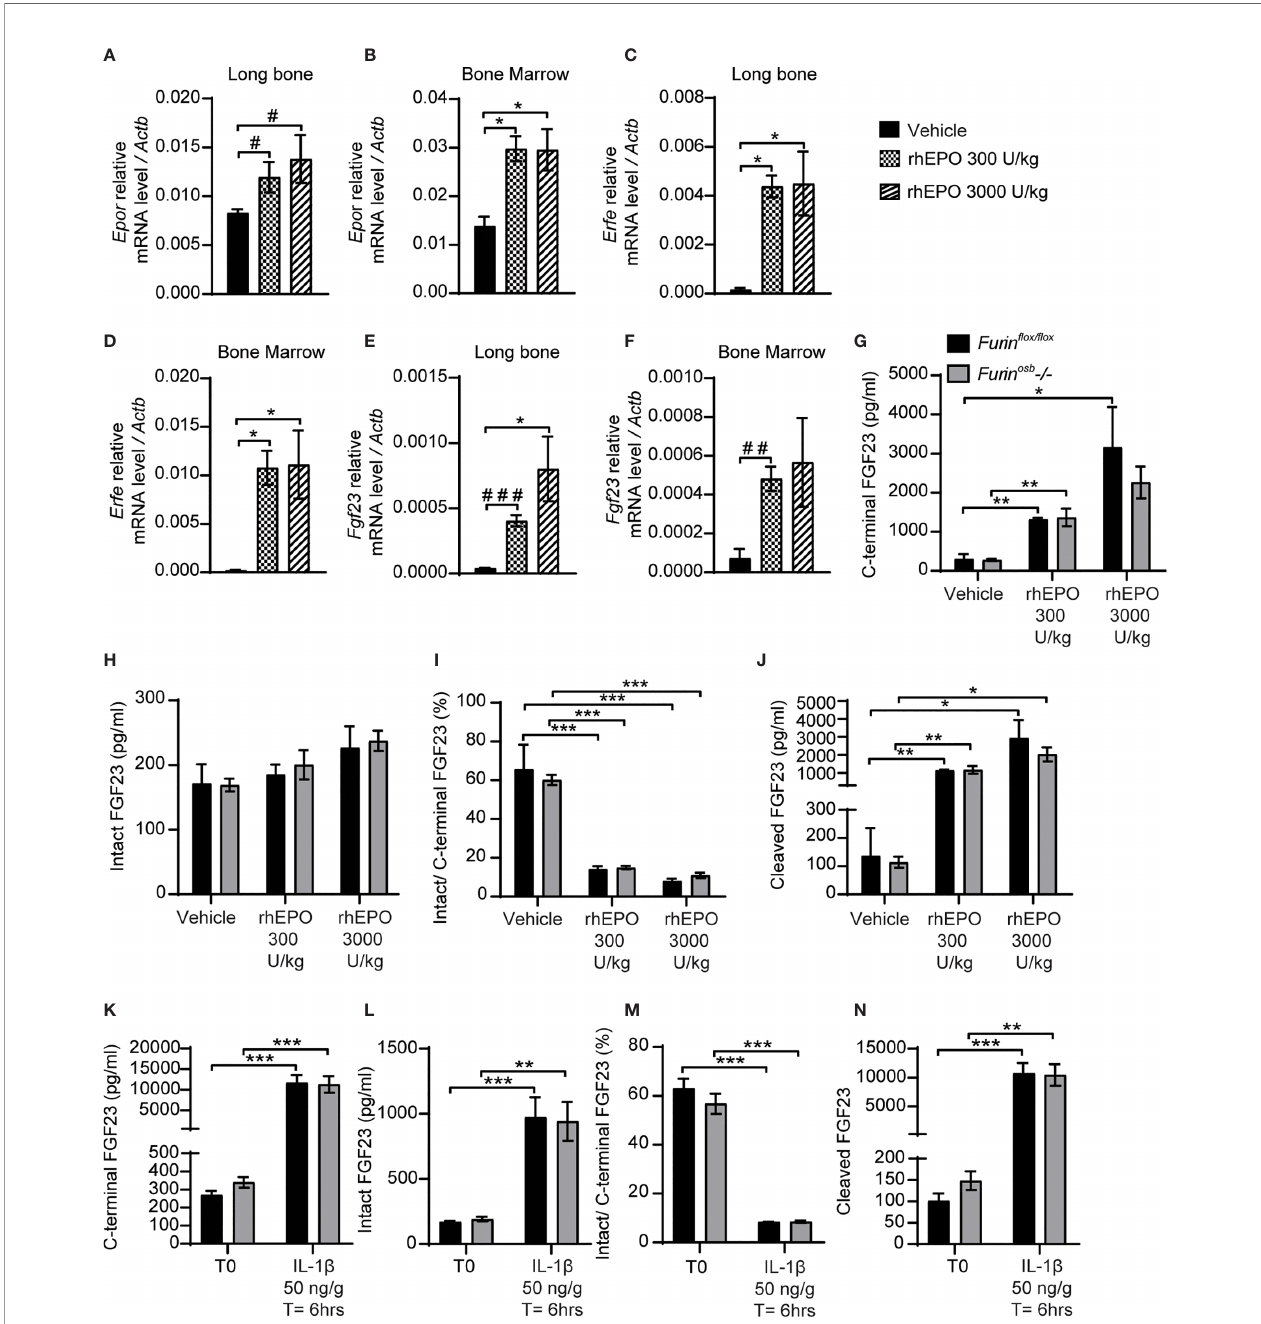
FIGURE 3 | FGF23 is normally processed following erythropoietin and IL-1 b injection in Furin osb -/- mice. Genes expression in long bone (A, B, E) and bone marrow (C, D, F) of 2-month-old C57BL/6J mice 6 hours following the injection of vehicle (n=4), 300 U/kg (n=4) or 3000 U/kg (n=4) of recombinant human erythropoietin (rhEPO). Erythropoietin receptor ( Epor ) (A, C) , erythroferrone ( Erfe ) (B, D) and FGF23 ( Fgf23 ) (C, F) . (G – J) Plasma FGF23 measurements in 4-month- old Furin fl ox/ fl ox (n=3) and Furin osb -/- (n=3) mice 6 hours following the injection of vehicle, 300 U/kg or 3000 U/kg of rhEPO. C-terminal FGF23 (G) , intact FGF23 (H) , percentage (%) of intact over C-terminal FGF23 (I) and cleaved FGF23 levels (J) , calculated as (C-terminal FGF23) - (intact FGF23). (K – N) Plasma FGF23 measurements in 4-month-old Furin fl ox/ fl ox (n=4) and Furin osb -/- (n=4) mice before (T0) and 6 hours following the injection of 50 ng/g IL-1 b (T=6hrs). C-terminal FGF23 (K) , intact FGF23 (L) , percentage (%) of intact over C-terminal FGF23 (M) and cleaved FGF23 levels (N) . Results represent the mean ± SEM. * P < 0.05, ** P < 0.01, and *** P < 0.001, by 1-way ANOVA (A – F) or 2-way ANOVA (G – N) with Bonferroni ’ s multiple comparisons test, or by Student ’ s t-test (A, E, F) #: P <0.05; ##: P <0.01, ###: P